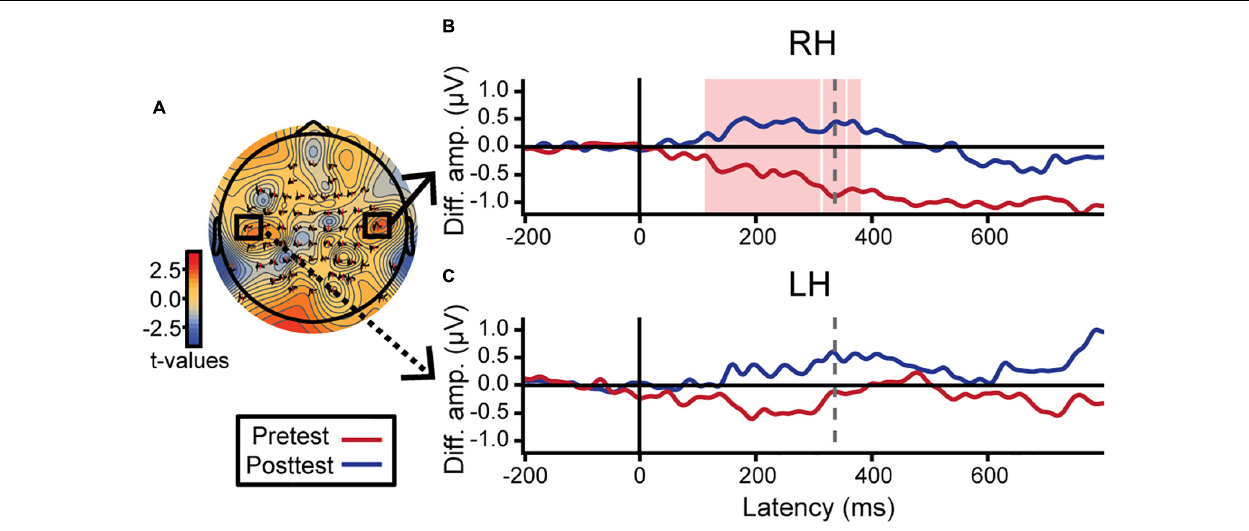
FIGURE 5 | Neuroplastic changes following auditory categorical learning of music intervals are biased toward right hemisphere. Only data for the learning group is shown. (A) Topographic statistical map at t = 336 ms (dotted gray line in B,C ) where pre- to post-test changes in categorical coding is maximal over the right hemisphere. Electrodes T7 and T8 are bordered by black squares. (B,C) Difference wave amplitudes [diff. amp.; i.e., mean(token 1 & 5) − token 3] indexing categorical neural coding (see text). An increase in neural categorization after training occurs over right ( B ; electrode T8) but not left hemisphere ( C ; electrode T7). The red shaded region in B indicates a significant effect of phase in the exploratory t -test (i.e., uncorrected). Average amplitudes were extracted from this time window (112–356 ms) for both hemispheres and subjected to more stringent statistical analyses (see text).